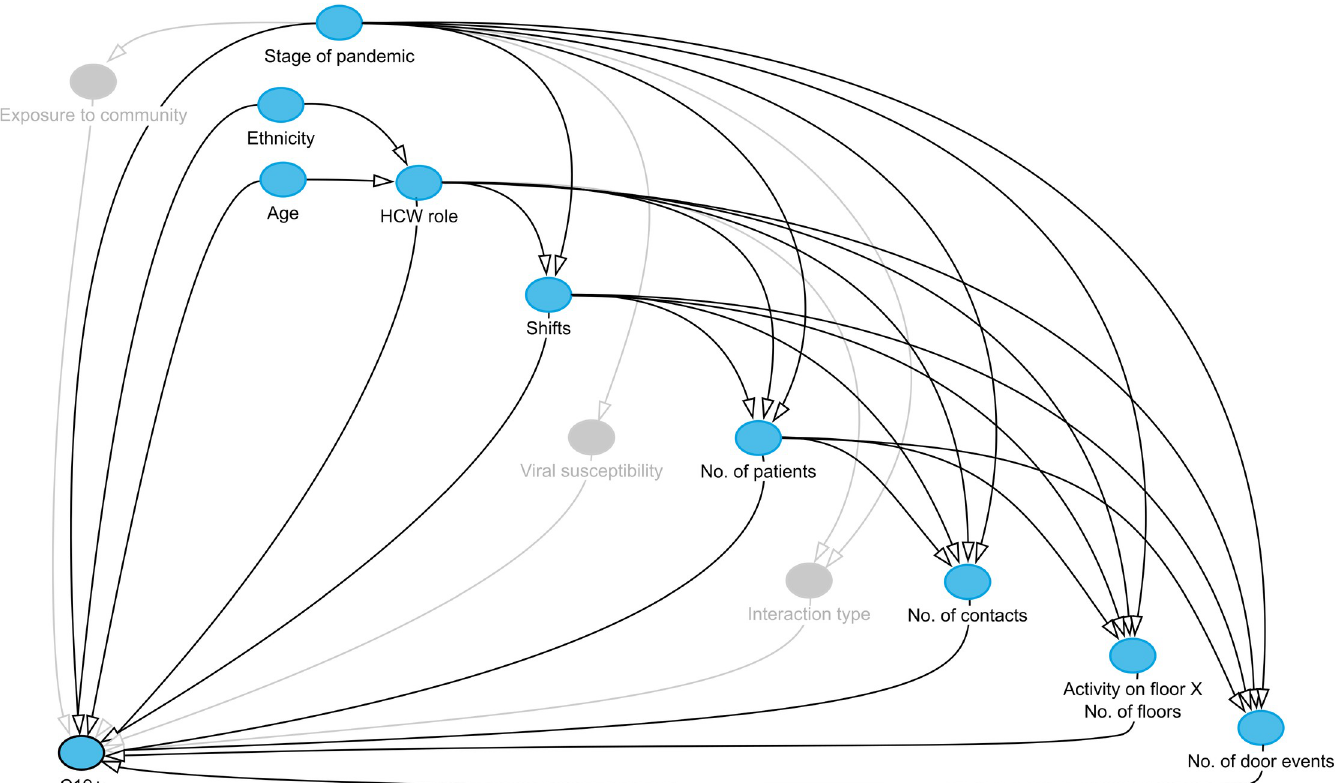
Fig 1. Directed acyclic graph (DAG). The DAG depicts the hypothesised relationships between variables considered to influence the probability of healthcare workers testing positive for COVID-19 (C19+). The blue nodes represent the observed variables and the grey nodes represent unobserved variables. Arrows connecting nodes show the (directional) relationship between